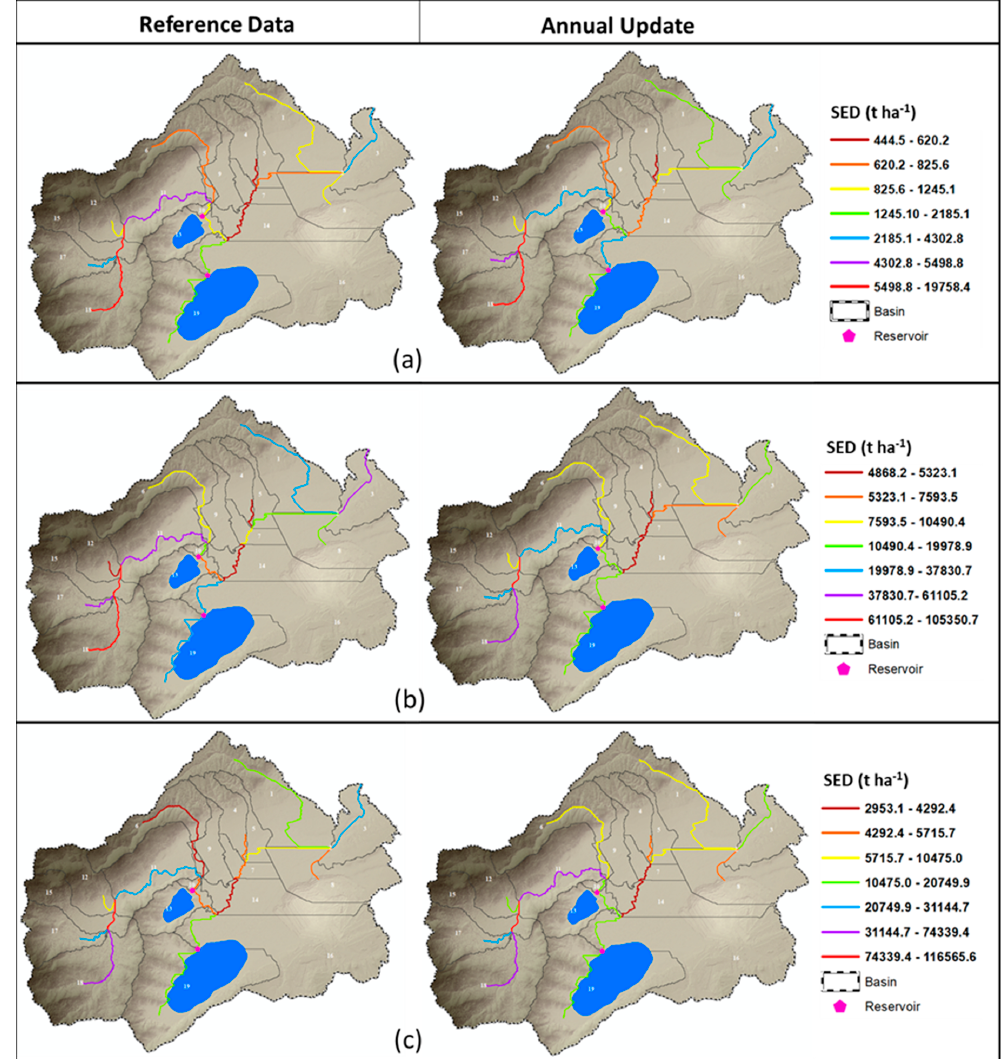
Figure 9. Comparison maps for the sub-river basin of Chimaditida and Zazari Lakes of sediment concentration for ( a ) 2017, ( b ) 2018 and ( c ) 2019. ISPRS Int. J. Geo-Inf. 2020 , 9 , x FOR PEER REVIEW